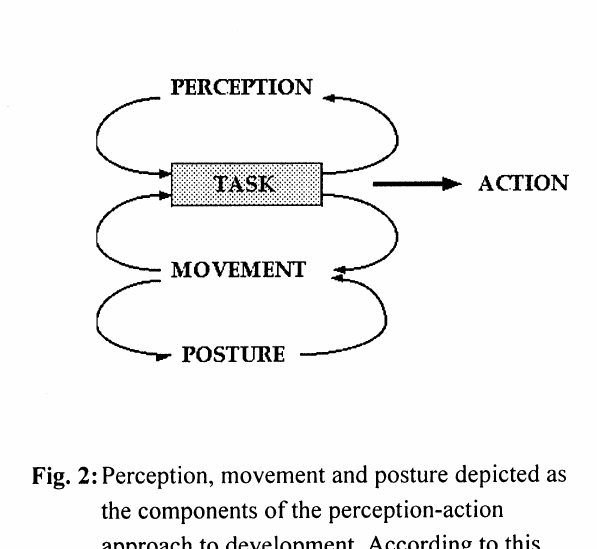
Fig. 2: Perception, movement and posture depicted as the components of the perception-action approach to development. According to this approach, developmental transformations in action are the result of changes in the task- specific couplings between the